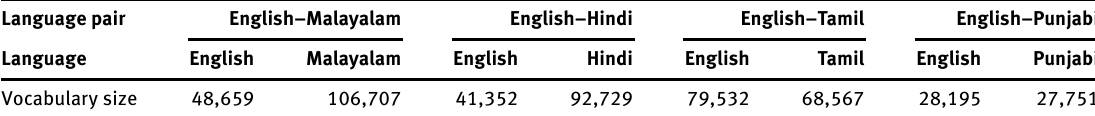
Table 2: Vocabulary Size in Each Language in Four Language Pairs. Language